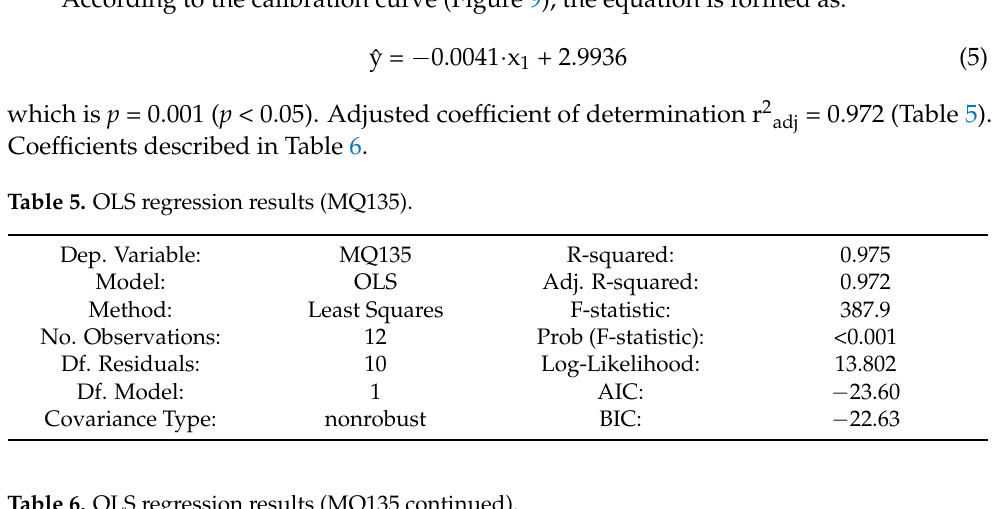
Table 6. OLS regression results (MQ135 continued).